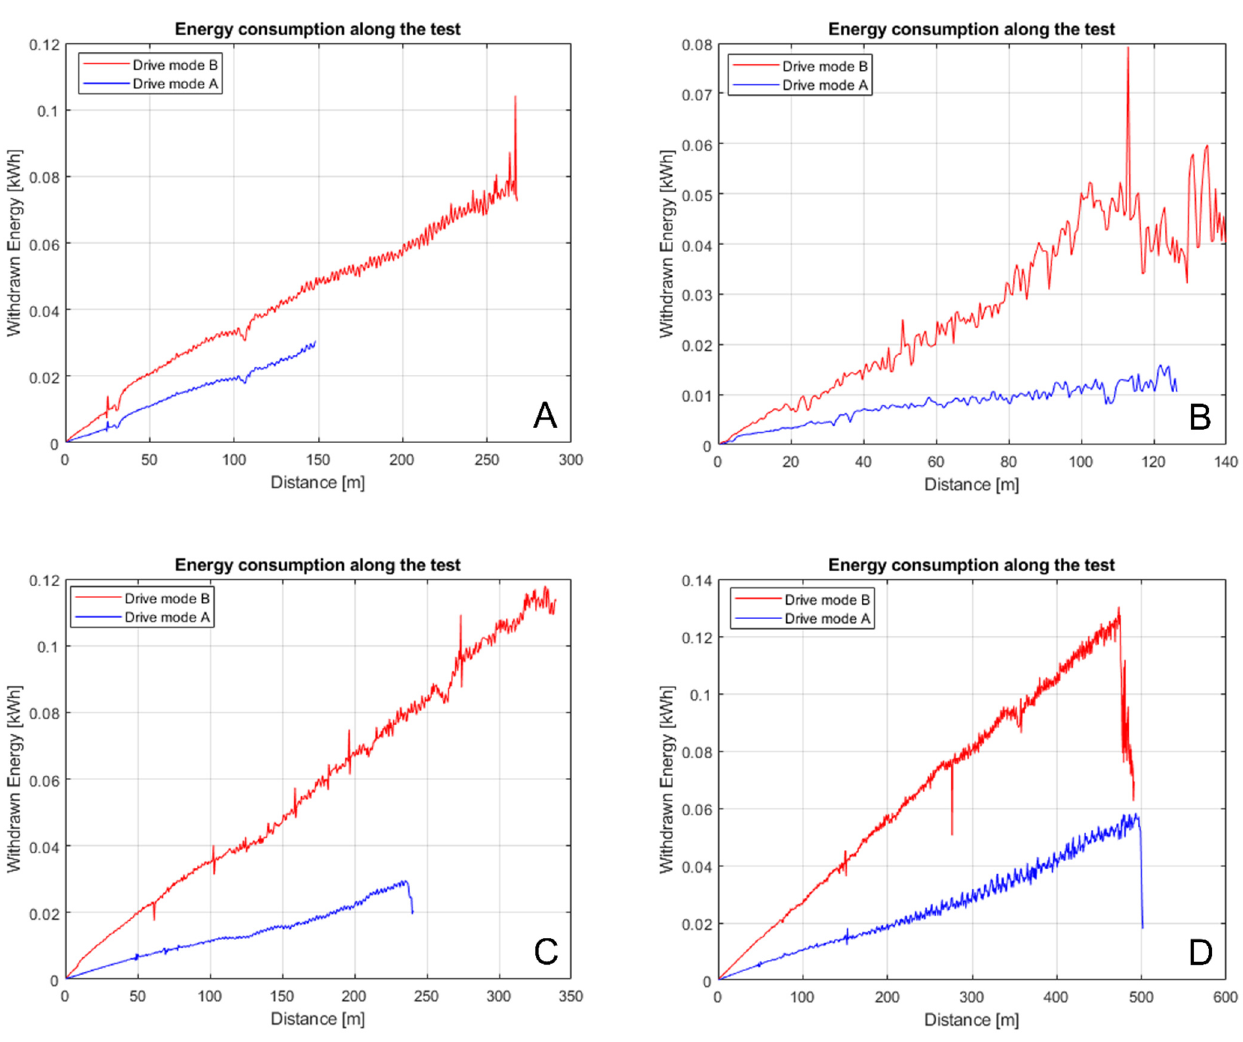
Figure 7. Behavior of the withdrawn energy in kWh along the test for the drive mode A and B. By: Authors. ( A ) Behavior of the withdrawn energy in kWh along the test 1 (in blue) and 5 (in red). ( B ) Behavior of the withdrawn energy in kWh along the test 2 (in blue) and 6 (in red). ( C ) Behavior of the withdrawn energy in kWh along the test 3 (in blue) and 7 (in red). ( D ) Behavior of the withdrawn energy in kWh along the test 4 (in blue) and 8 (in red).